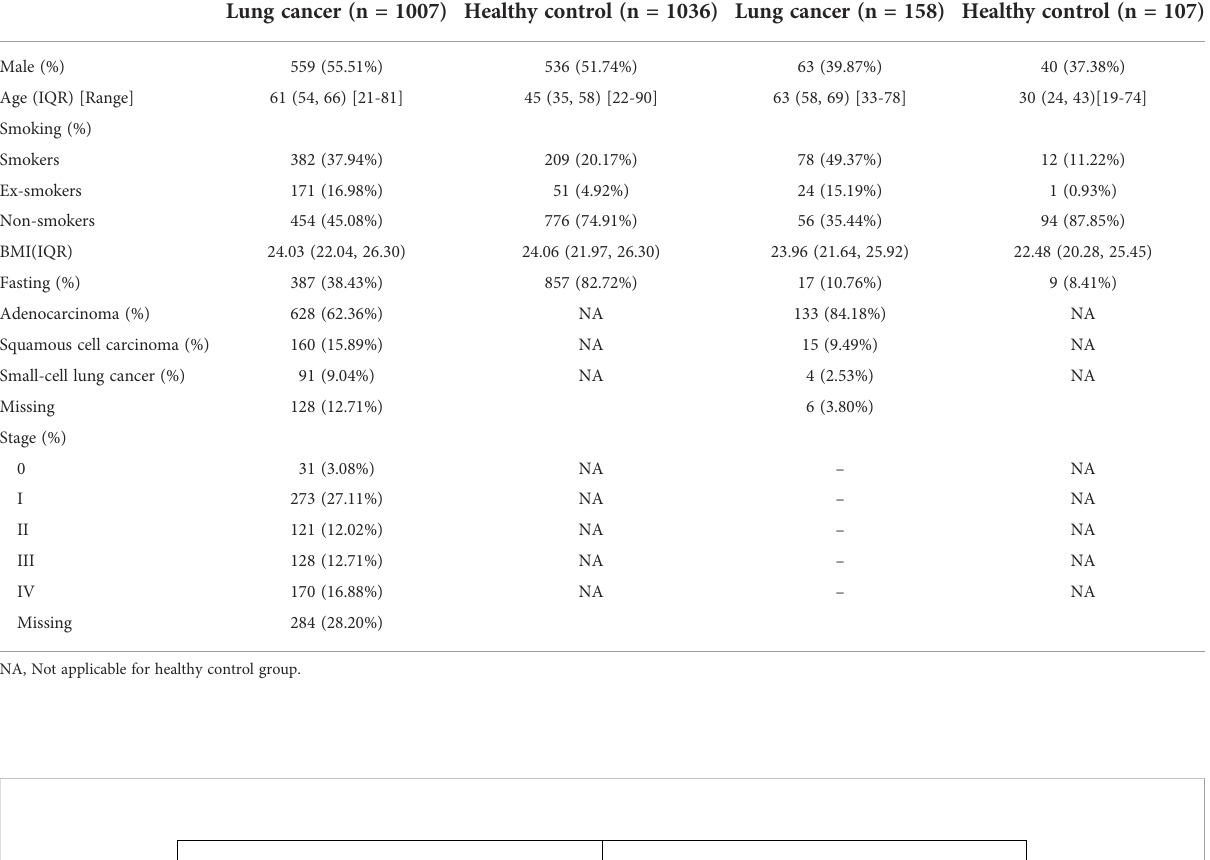
TABLE 1 Baseline characteristics of the individuals included in the study.